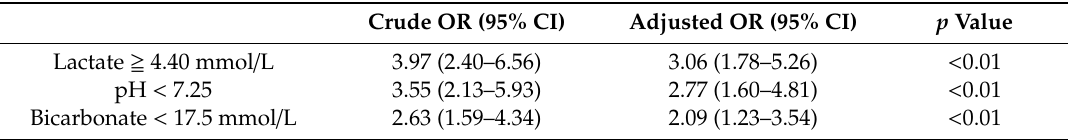
Table 2. Predictors of 28-day mortality in children with acute kidney injury by uni- and multivariate logistic regression.